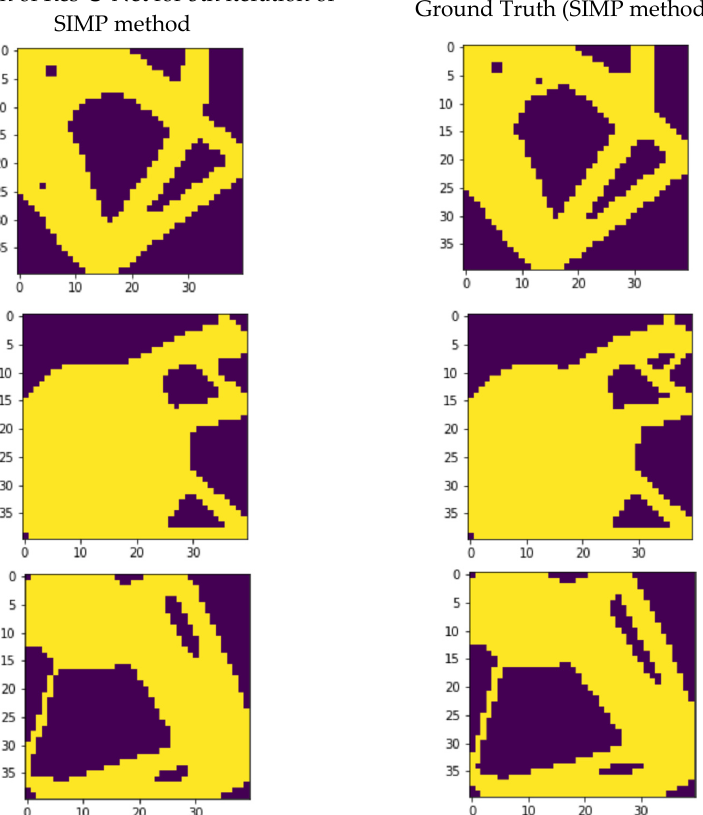
Table 2. Experiments results of 10-fold cross validation accuracy of Res-U-Net and U-Net models.